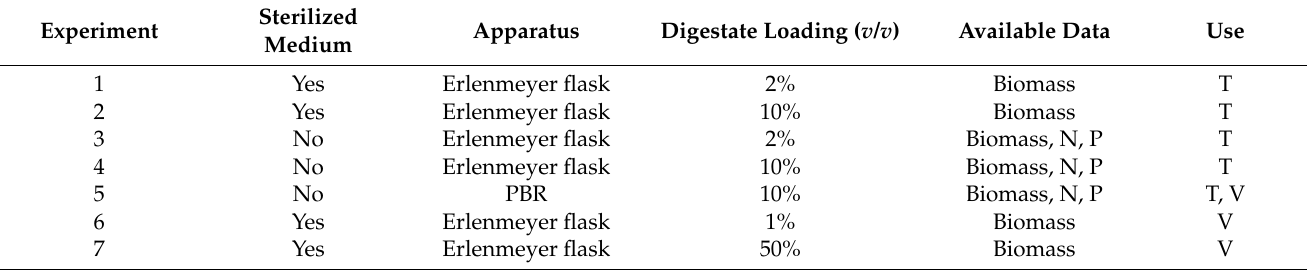
Table 1. Description of the experiments used in proposed model training and validation.